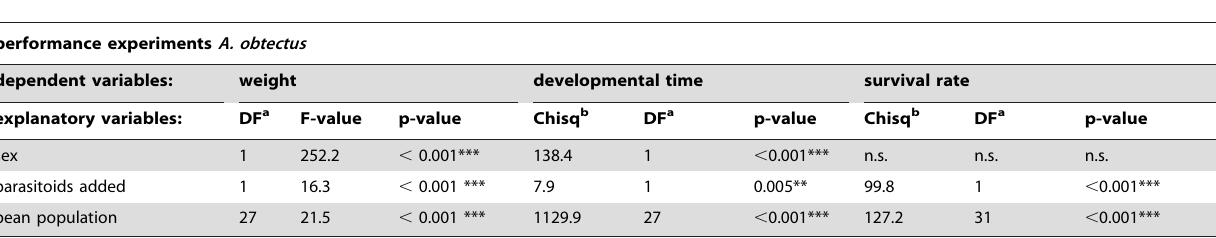
Table 3. Performance experiments with A. obtectus on beans of 26 wild bean populations from Mexico.